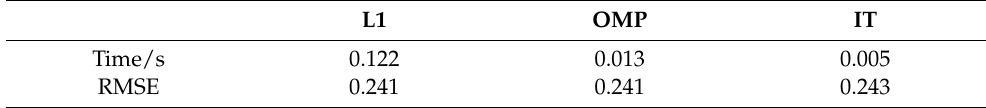
Table 2. Average value of time and quality, reconstructed by different